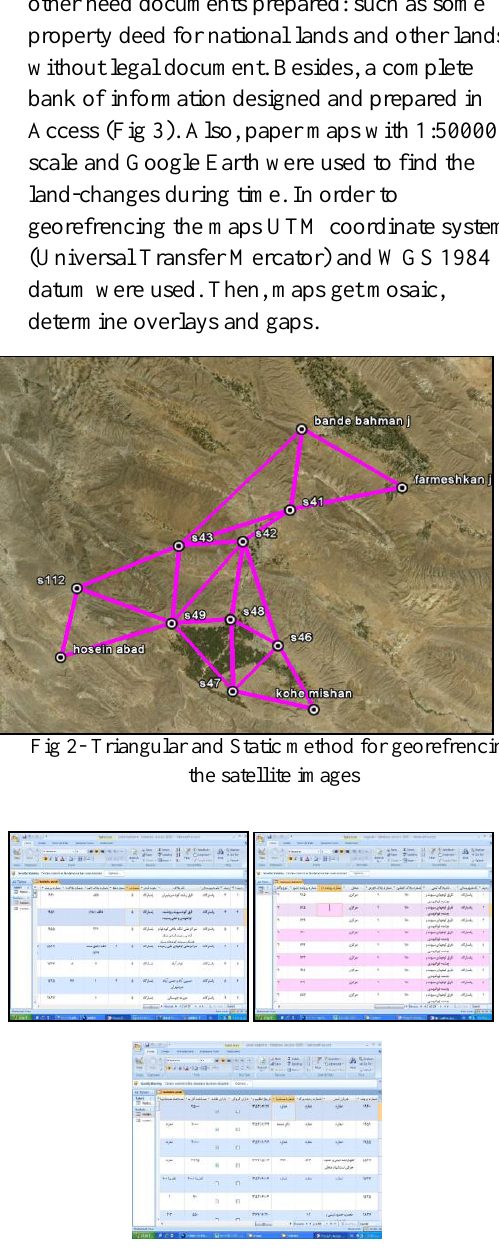
Fig 3- The sample of prepared bank for land